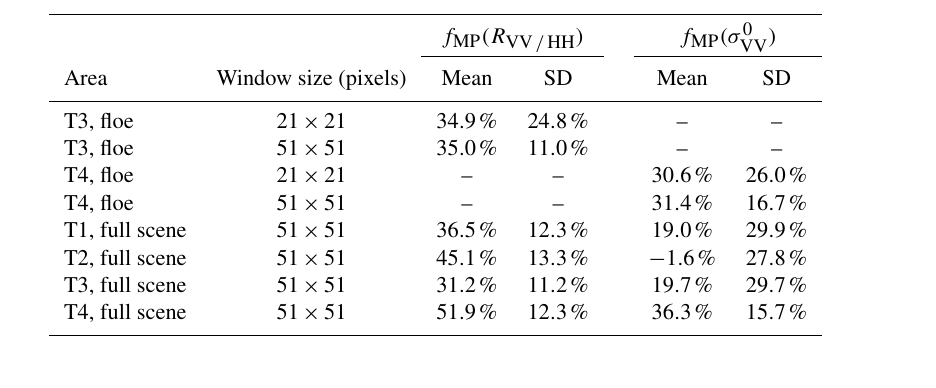
Table 5. Statistics of modelled f MP distributions.